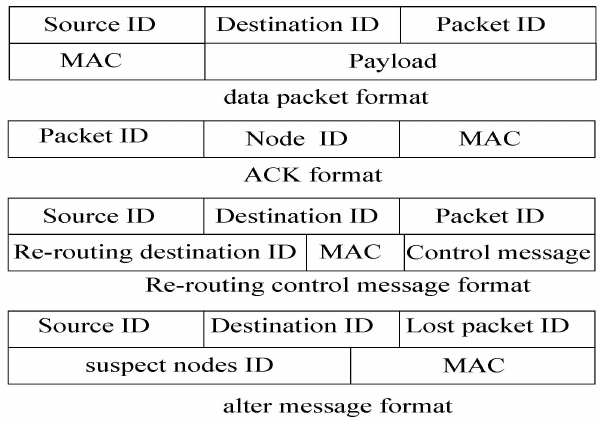
Figure 3. Packet format.